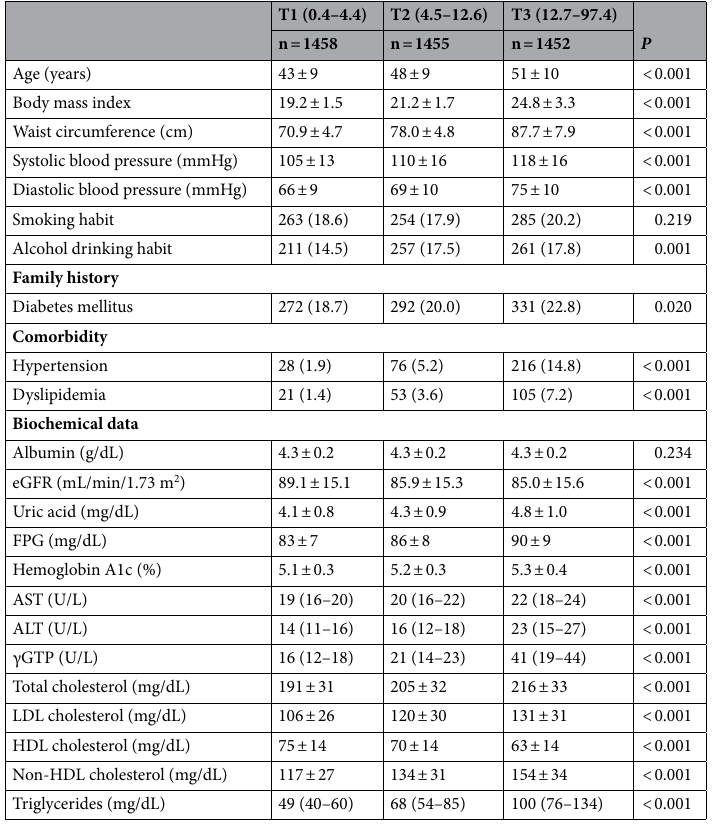
Table 3. Characteristics of female subjects divided by tertiles of FLI at baseline (n = 4365). Variables are expressed as number (%), means ± SD or medians (interquartile ranges). AST aspartate aminotransferase, ALT alanine aminotransferase, eGFR estimated glomerular filtration rate, FLI fatty liver index, FPG fasting plasma glucose, γGTP γ-glutamyl transferase, HDL high-density lipoprotein, LDL low-density